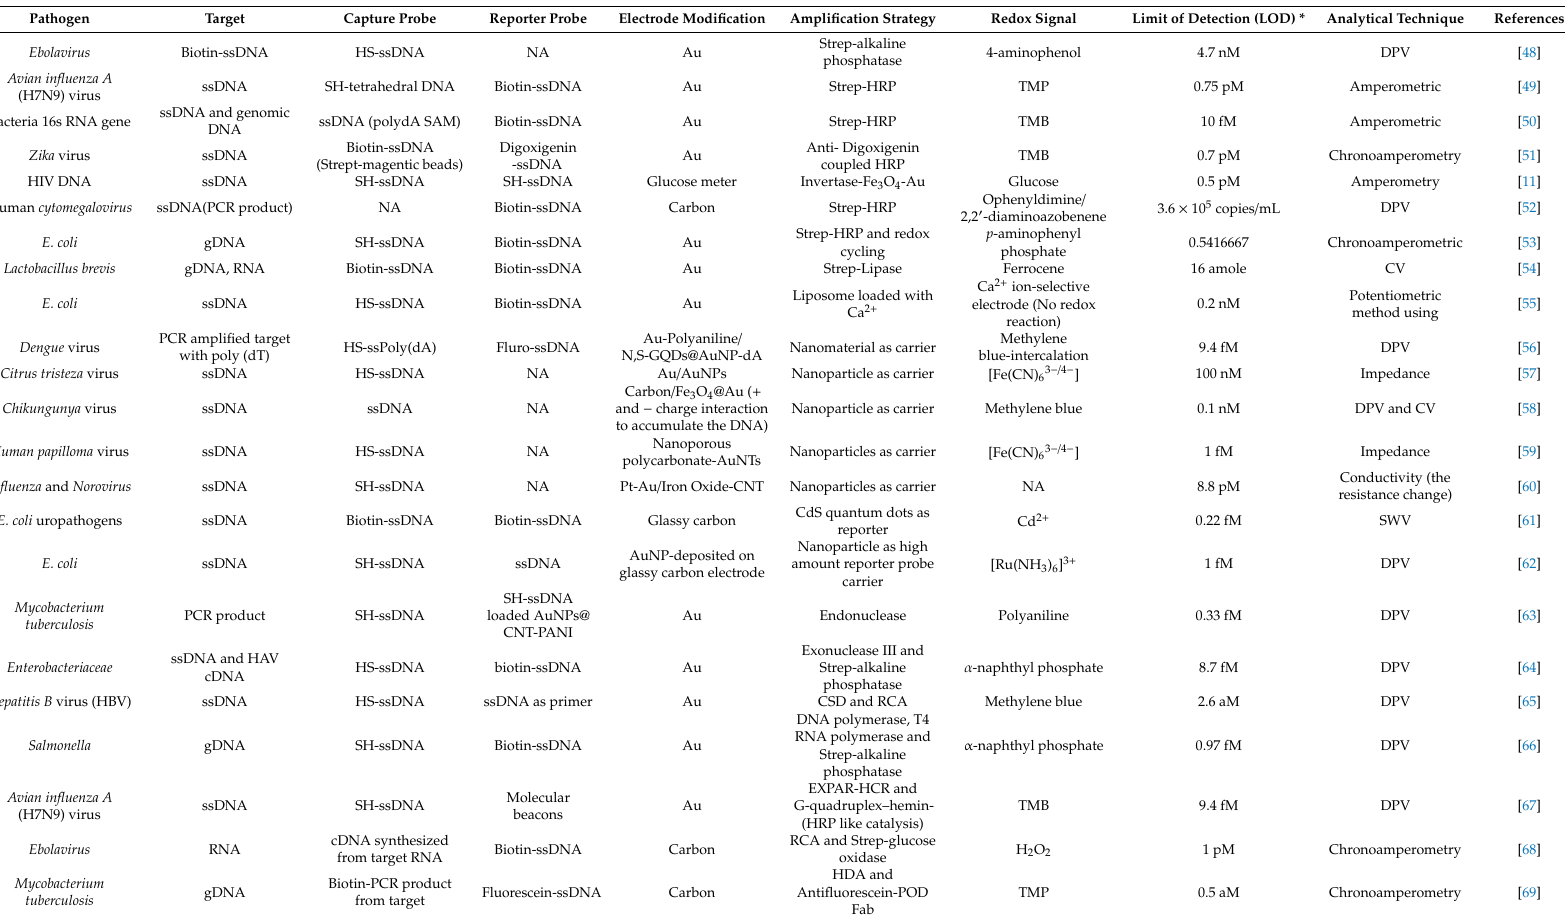
Table 2. Various signal amplification strategies employed for the detection of pathogenic DNA using electrochemical analytical